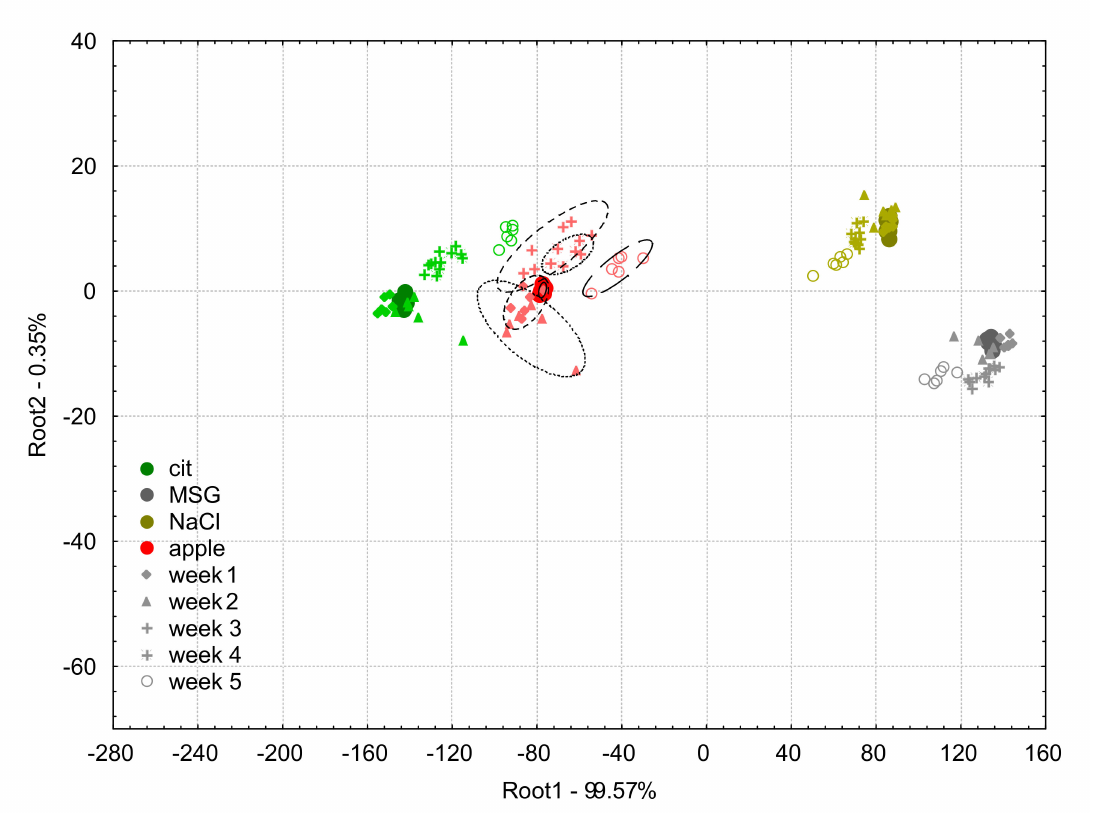
Figure 7. Linear discriminant analysis plots for the drift corrected dataset using the additive correction relative to reference samples method of the e-tongue measurements of apple juice samples (red symbols) and model solutions: citric acid (green symbols), NaCl (gold symbols), and MSG (gray symbols). The solid circles indicate the measurements on week 0 which was used to build the linear discriminant analysis model, and the di ff erent symbols (diamond, triangle, plus, asterisk, and circle) stand for the di ff erent weeks 1–5,